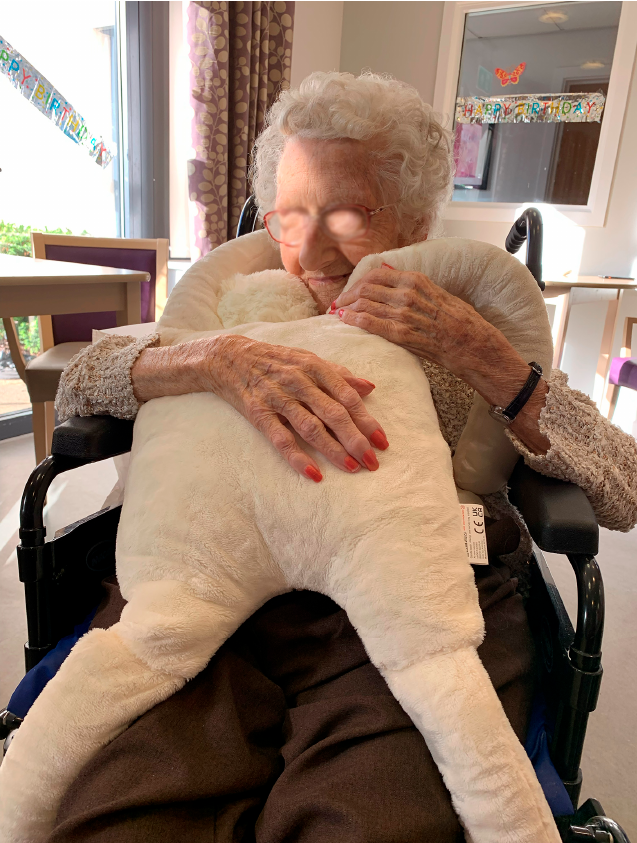
Figure 8. Person living with dementia using a manufactured HUG.